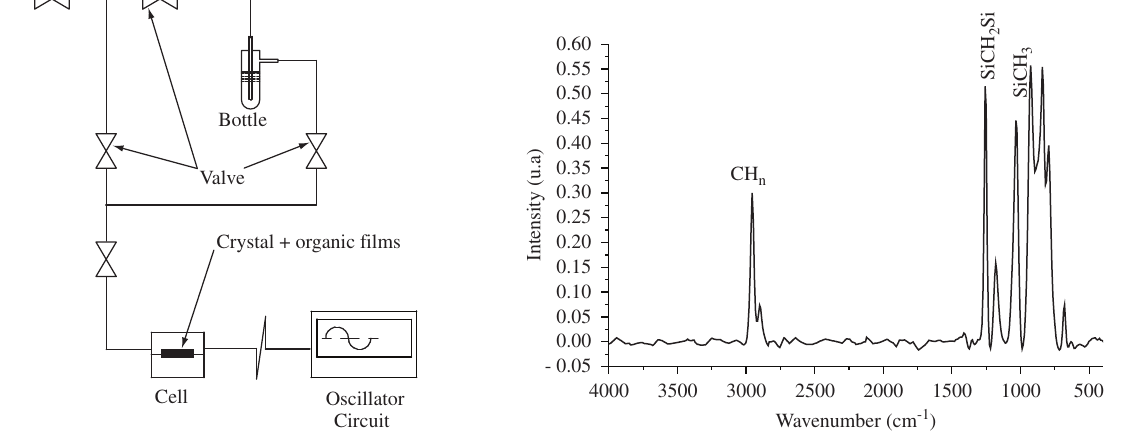
Figure 2. Quartz crystal microbalance system used for adsorption tests. Figure 3. Typical HMDS film spectrum with 0.3 Torr, 400 W, 5